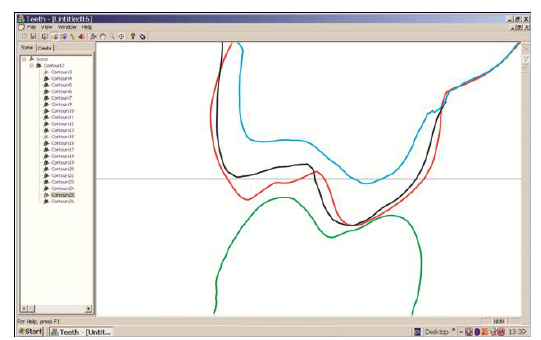
Figure 10. Combined contours of teeth, prepared teeth and